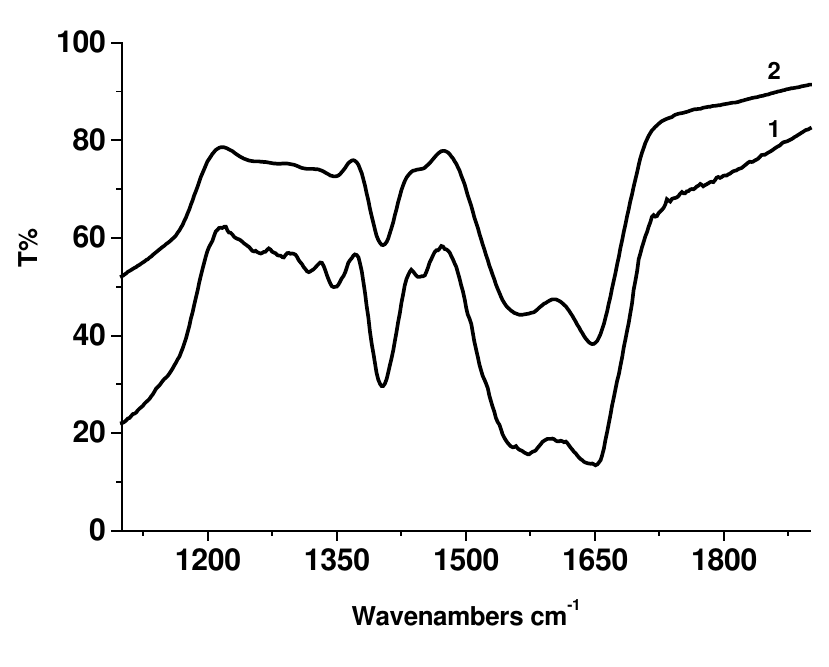
Fig.4. FT-IR spectra of a cast glucose oxidase film on a silicon wafer (1) and a glucose oxidase film covering a SWNT-modified silicon